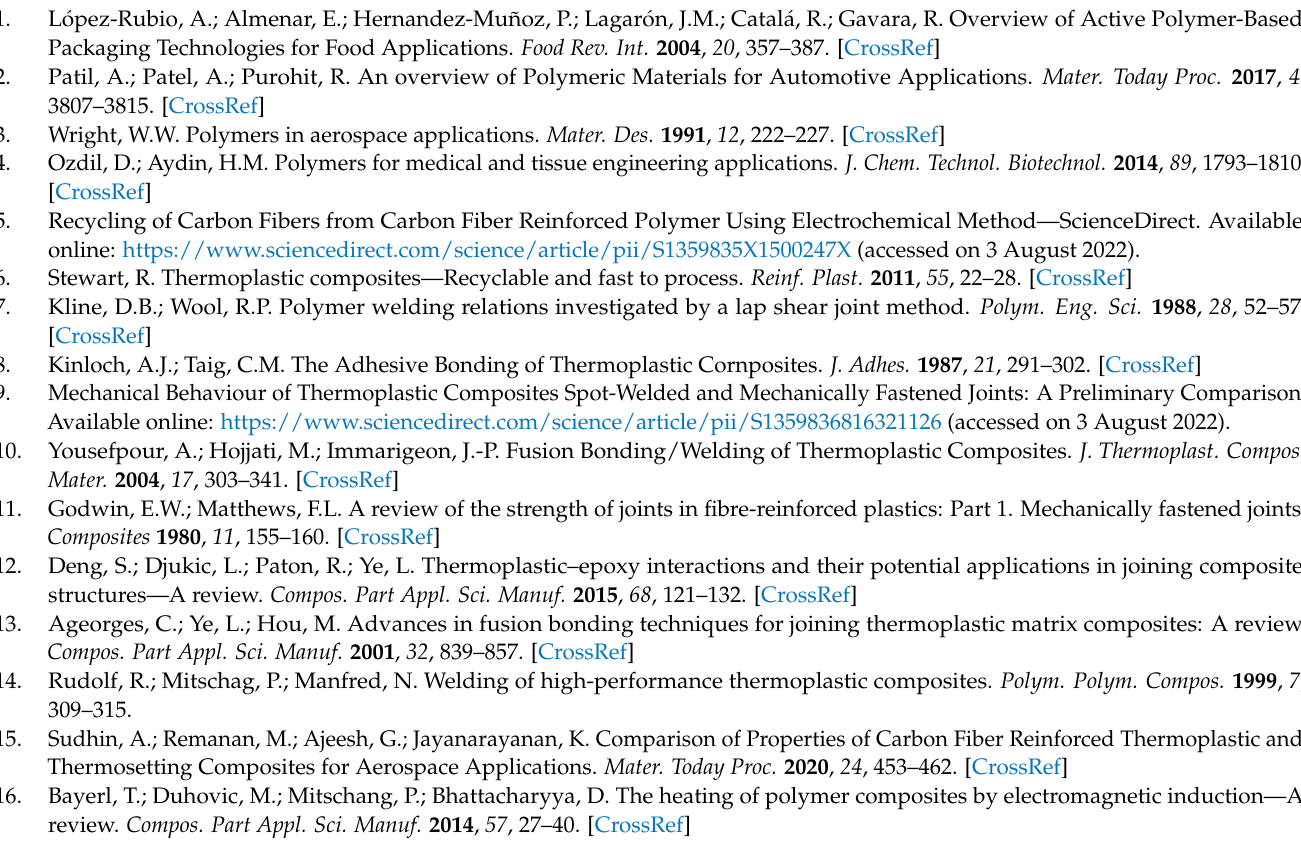
using servo-hydraulic testing machine. Figure S2: Average displacement of (a) center bondline and (b) top surface measured after RF welding for defined welding parameters. Figure S3: Center and surface displacement for specific displacement values varying with the graphite density. Figure S4: Center and surface displacement for different values of applied pressure. Figure S5: Center and surface displacement for different values of applied